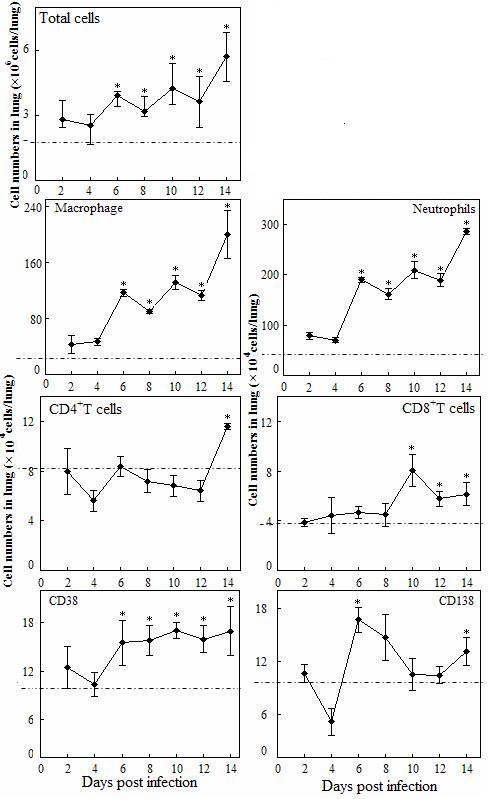
Kinetics of pulmonary immune cells in mice with fatal dose (5 × 105 p.f.u.) of A/PR/8/34 (H1N1) virus infection. The frequencies of macrophages (CD11b+/CD11c−/Ly6G/c−) and neutrophils (CD11b+/CD11c−/Ly6G/c+) were determined by appropriate gating within the total lung leukocytes. For determination of the frequencies of CD4+ and CD8+ T cells, the CD3+ T cells were first determined by appropriate gating within the pulmonary lymphocytes, and then CD4+/CD8−T cells and CD4−/CD8+ T cells were detected by gating within the CD3+ T cells. In the detection of frequency of CD138+ cells and CD38+ cells, B220/CD45R was used to identify different B cell subtypes within the pulmonary lymphocytes, then CD138+ and CD38+ B cells were determined by appropriate gating within the determined B cell subtype, respectively. Mice without infection were used as the control group. Mean lung cell numbers were representative of at least 3 mice lungs per time point group, and error bars indicated the standard deviations. The dotted lines were the control level. *p < 0.05 compared with control group.